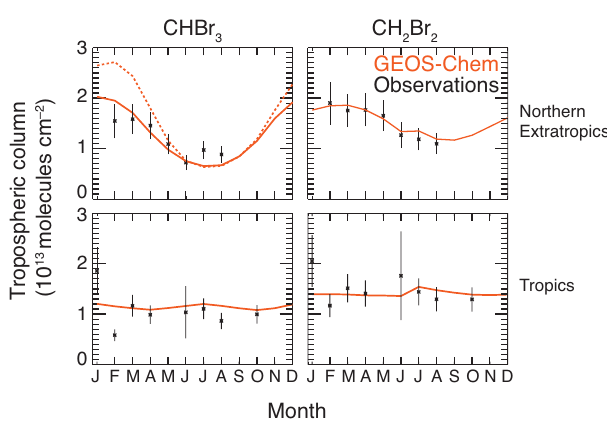
Fig. 2. Comparison of simulated (red) and observed (black) tropo- spheric columns (molecules cm − 2 ) of CH 2 Br 2 and CHBr 3 , for the northern extratropics ( > 30 ◦ N) and the tropics (30 ◦ S–30 ◦ N). Col- umn data are integrals of mean vertical profiles up to 10km alti- tude from a compilation of NASA campaigns including STRAT, TRACE-P, INTEX, AVE, TC4, and ARCTAS in the northern extra- tropics and STRAT, PEM-Tropics, TRACE-P, INTEX, Pre-AVE, AVE, and TC4 in the tropics. References for the observations are in Liang et al. (2010). Vertical bars are the standard deviations in the original data. The dashed red line shows the model results for CHBr 3 in the northern extratropics using the original aseasonal emissions from Liang et al. (2010); in order to match the observa- tions in GEOS-Chem we applied seasonal scaling factors to CHBr 3 emissions in that region (solid red